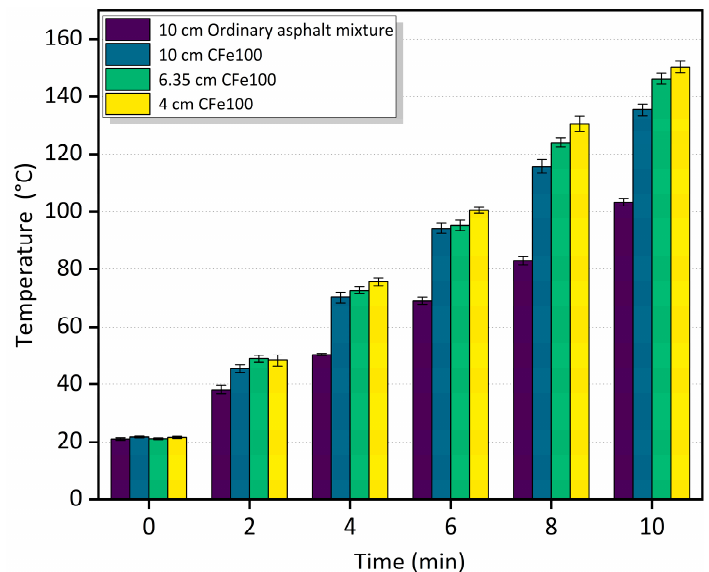
Figure 15. Temperature change for different thicknesses of the asphalt mixtures with a 100% re- placement rate of CFe.